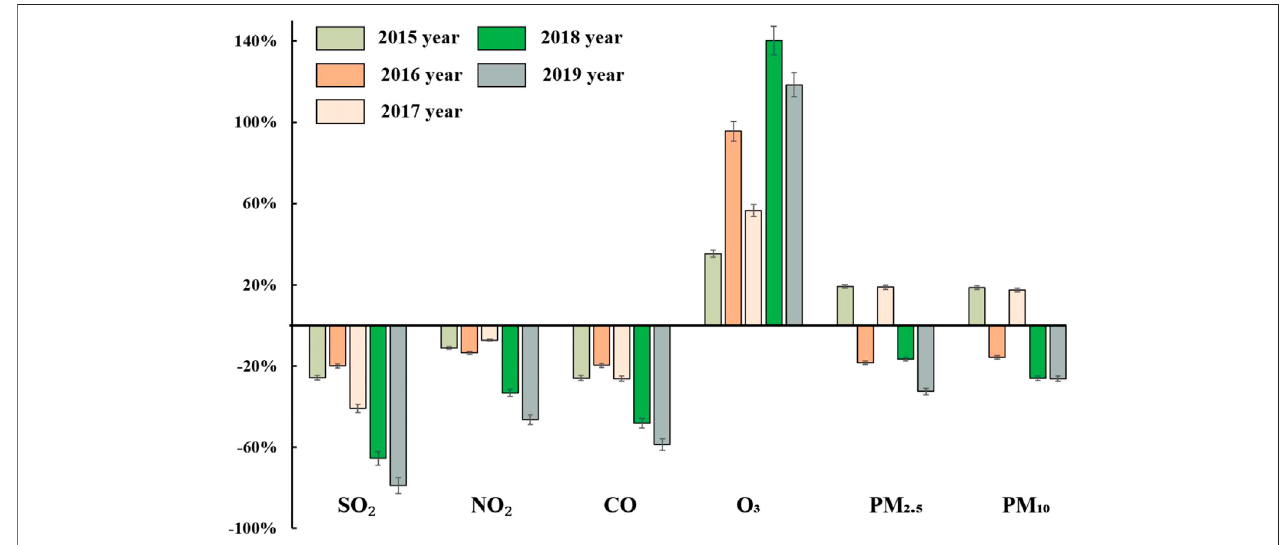
FIGURE 6 | average concentration changes of these pollutants from 2015 to 2019 compared to those during Spring Festival periods 2014.